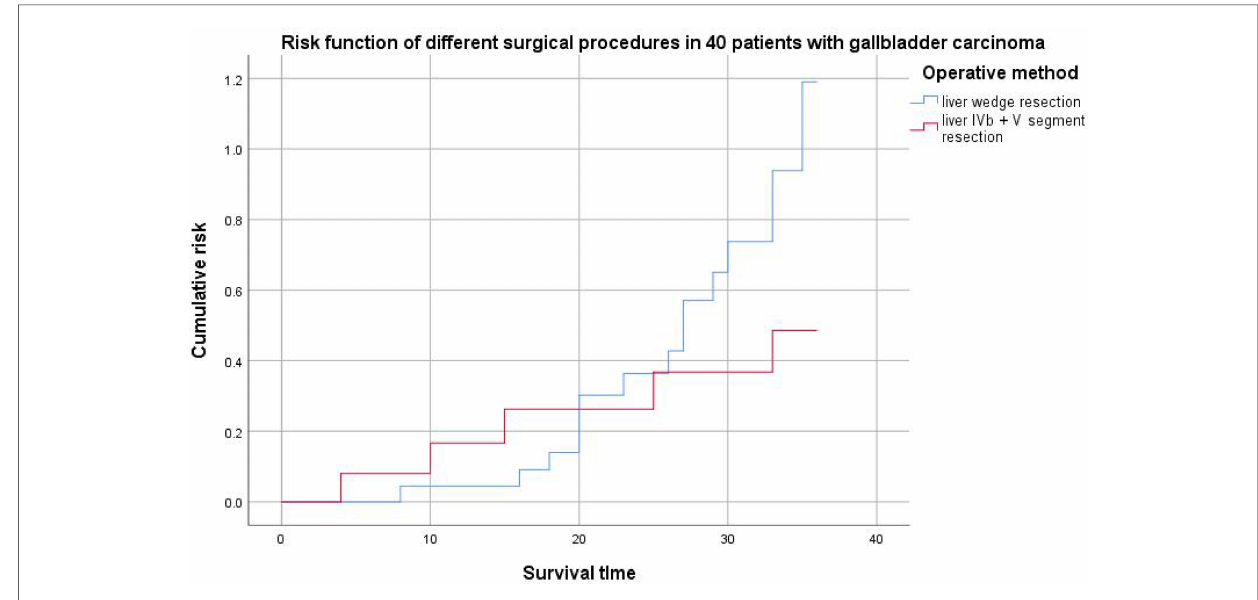
FIGURE 3. Risk function of surgical procedures in 40 patients with gallbladder